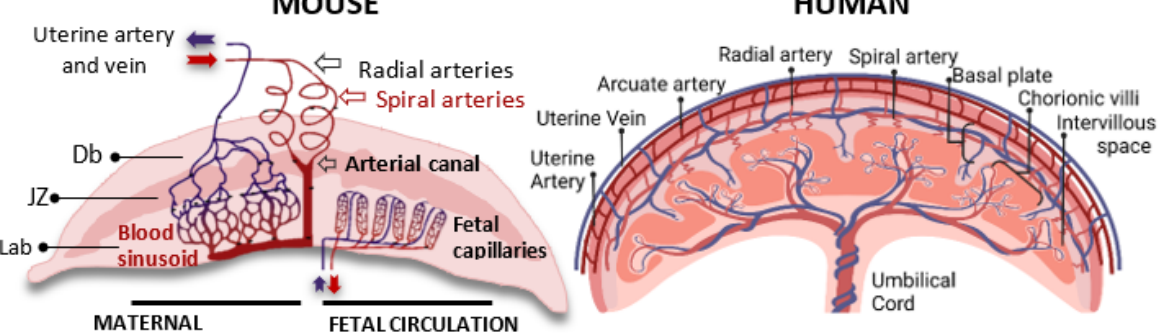
Figure 2. Organization of the utero-placental vascular system in mice and humans. In mice, as in humans, the placental vascular tree originates from the highly resistant uterine arteries (UAs), which branch into radial arteries (RAs) and then terminate in the spiral arteries (SAs). The SAs supply the decidua at the implantation site. Moreover, in the mouse placenta, the SAs fuse in order to form the centrally located arterial canals (CCs), which supply maternal blood to the fetal compartments of the placenta. The CCs enter the junctional zone (JZ) and generate maternal arterial sinusoids in the labyrinth. Moreover, the maternal sinusoids interdigitate with the dense capillary network of the fetal vasculature and thus create the interface for nutrient and gas exchange. The oxygen-poor blood flow returns to the vascular channels of the JZ, which become venous sinusoids just above the JZ and terminate in the uterine vein. In this simplified diagram, part of the maternal circulation is shown on the left. In addition, part of the fetal circulation is illustrated on the right. In humans, the spiral arteries open into the intervillous spaces of the placenta where the maternal blood passes over the surfaces of the placental villi, which contain fetal capillaries. After maternal–fetal exchange, blood from the intervillous space is drained by the utero-placental veins, the openings of which are on the floor of the intervillous space. The diagram on the left was adapted from The Guide to Investigation of Mouse Pregnancy, Croy, A. 2014 [3].